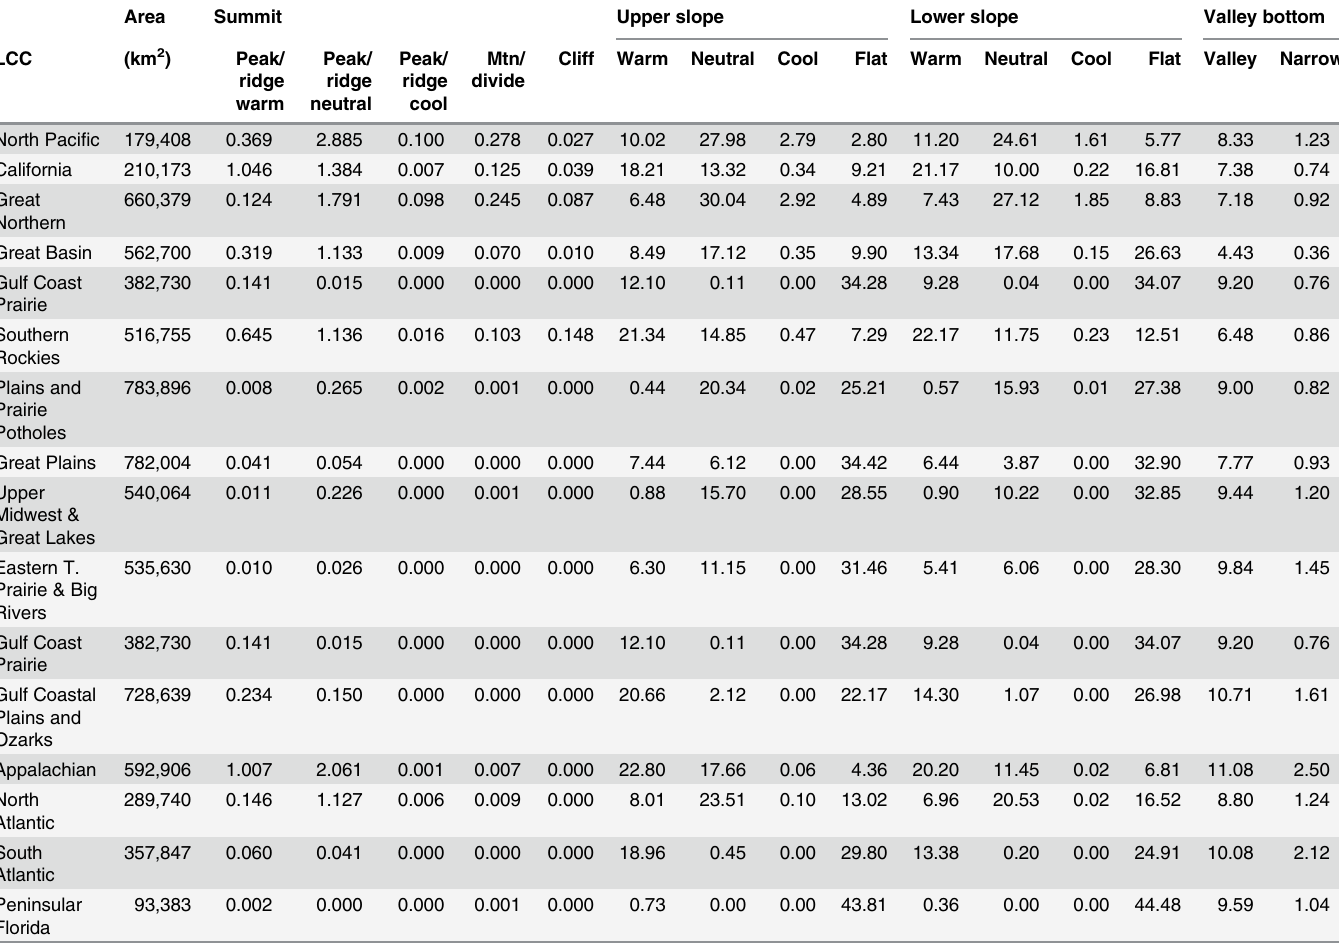
Table 3. Ecoregional distribution of